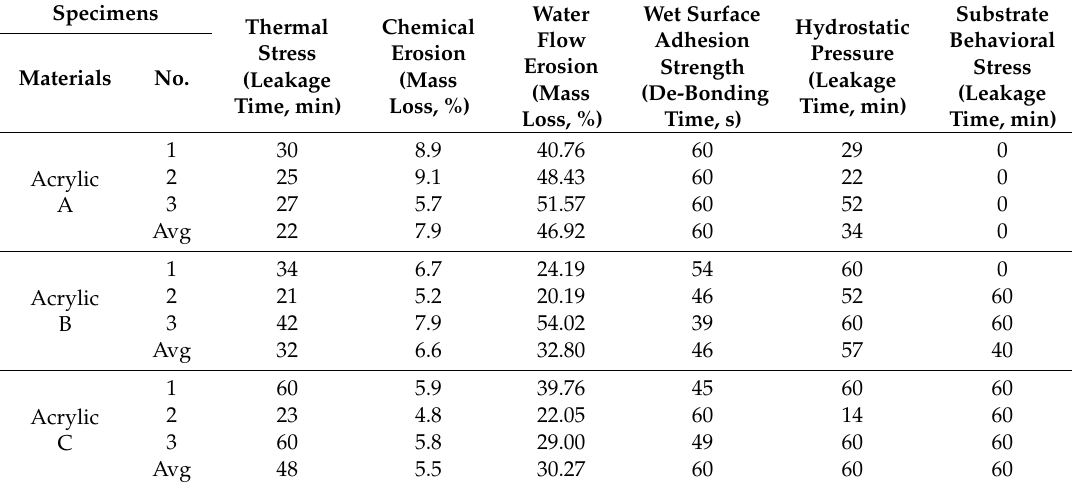
Table 6. The evaluation results of the acrylic-resin grout-injection material. Specimens